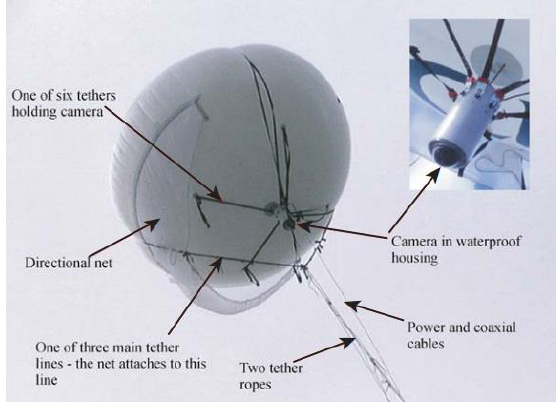
Figure 1. Aerial systems, such as the “blimp-cam” from Hodgson (2007) provide video data on subsurface behavior and group configurations. Smaller balloons combined with kites (Lewis et al., 2011) have replaced older setups that are larger and more expensive (Nowacek et al.,